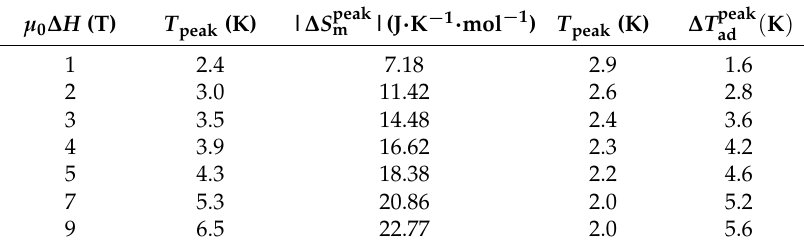
Table 1. Peak values of ∆ S m and ∆ T ad of 1 .